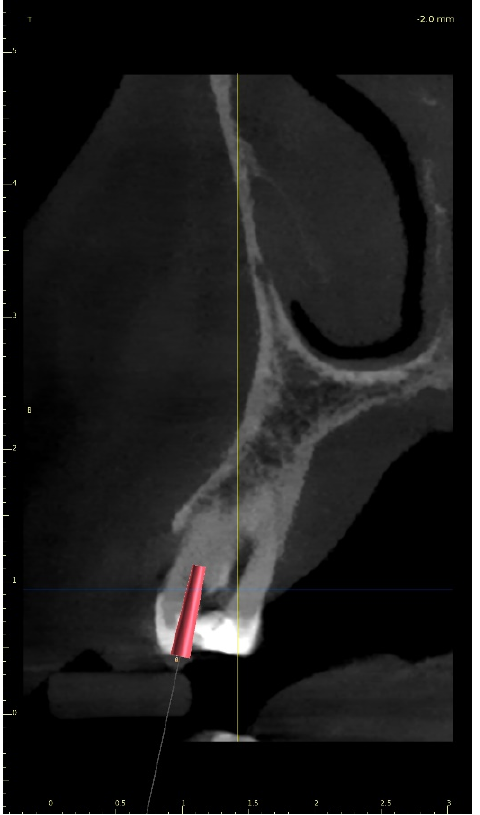
Figure 26. CBCT image presenting virtual implant positioned through the centre of the buccal root, as canal was nonvisible.